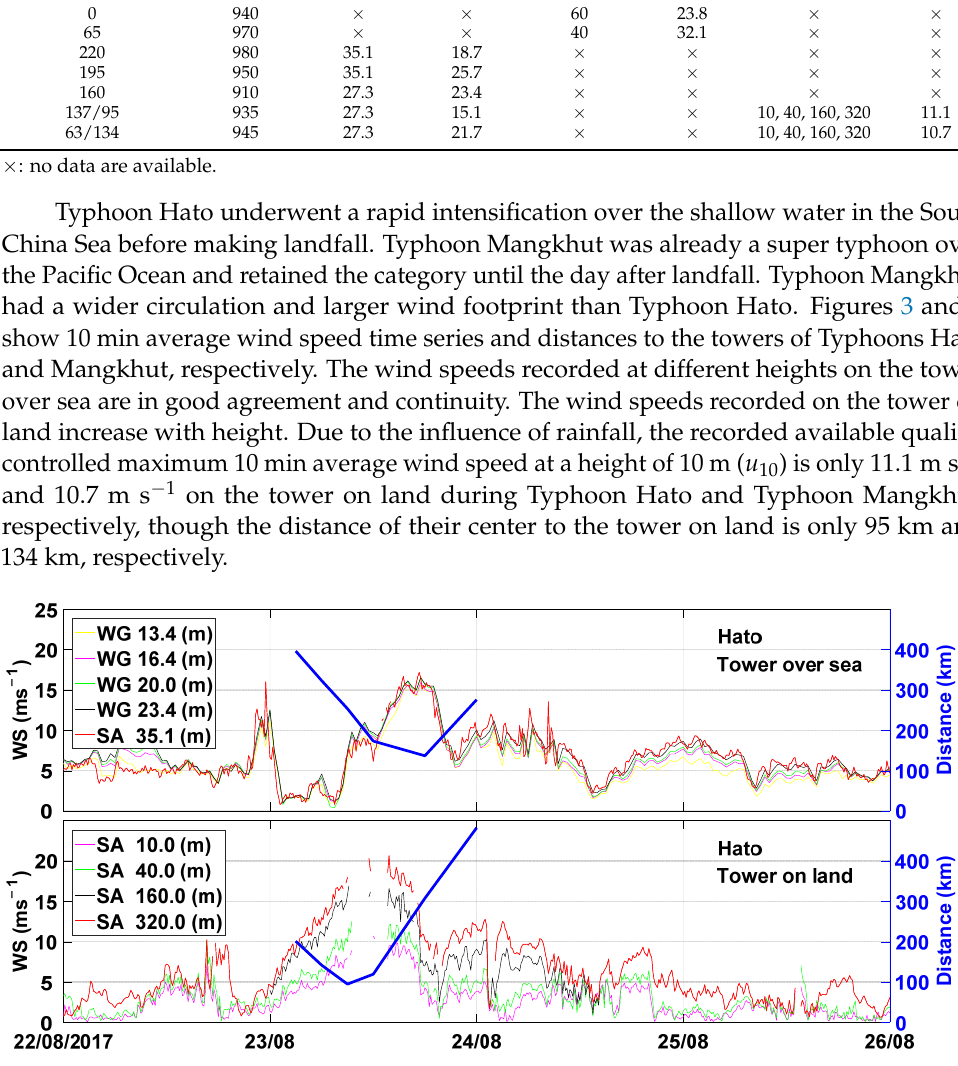
Figure 3. The raw 10 min average wind speed (WS) and the distance of the typhoon center to the tower (data obtained from the website http://tadata.typhoon.org.cn/) (accessed on 1 August 2022) [17] during Typhoon Hato. ( top ) The WS observations derived from the sonic anemometer (SA) and the standard wind gauges (WG) at the tower over sea and ( bottom ) the data derived from the sonic anemometers (SA) at the tower on land.